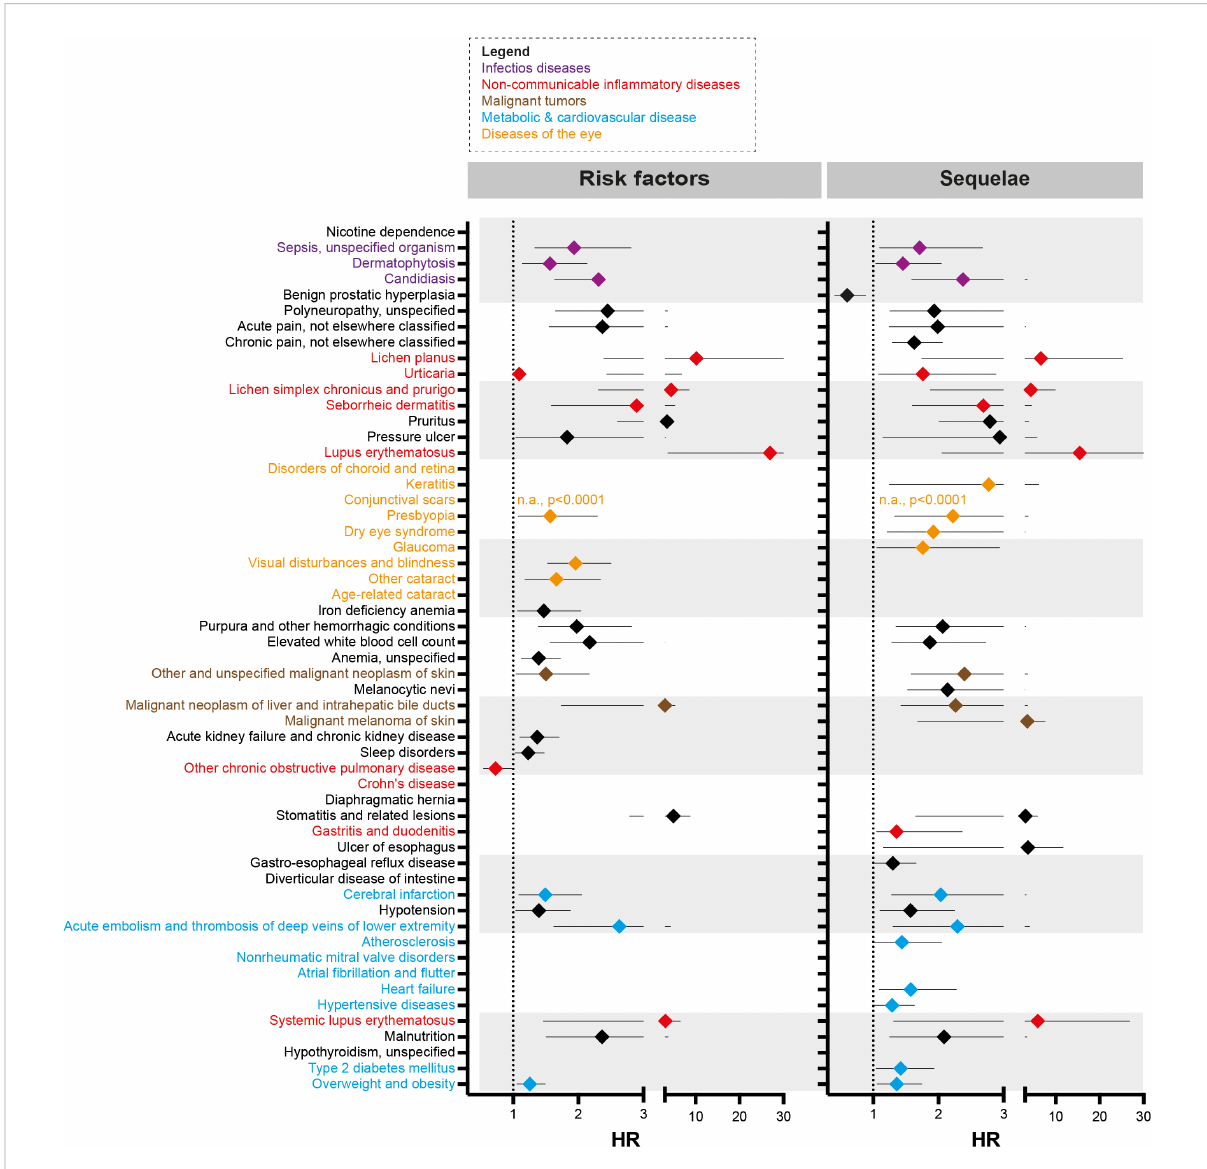
FIGURE 2 Risk factors and sequelae of epidermolysis bullosa acquisita. Hazard ratio (HR) event plots for the risk factors and sequelae of epidermolysis bullosa acquisita (EBA). Cohort descriptions and detailed results for risk factors are listed in Supplement Tables 1 – 55 and Table 1, respectively. For risk factors, these are shown in Supplement Table 56 and Table 2. Error bars indicate 5/95-percentiles. If no HR is shown, the indicated disease was not a risk factor / sequela of